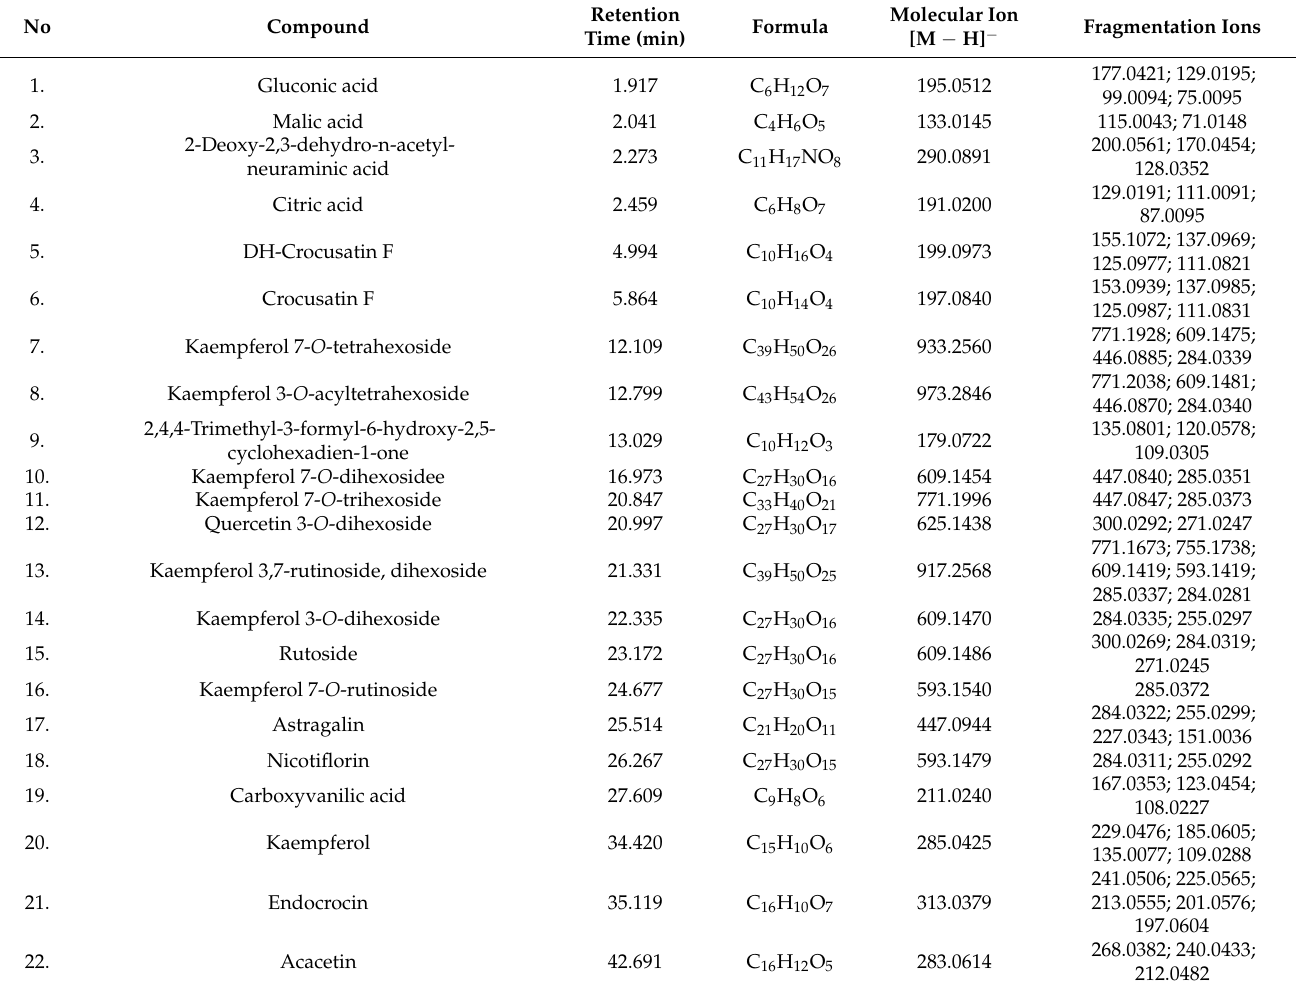
Table 1. Chromatographic data of compounds identified by HPLC/ESI-QTOF-MS in CA